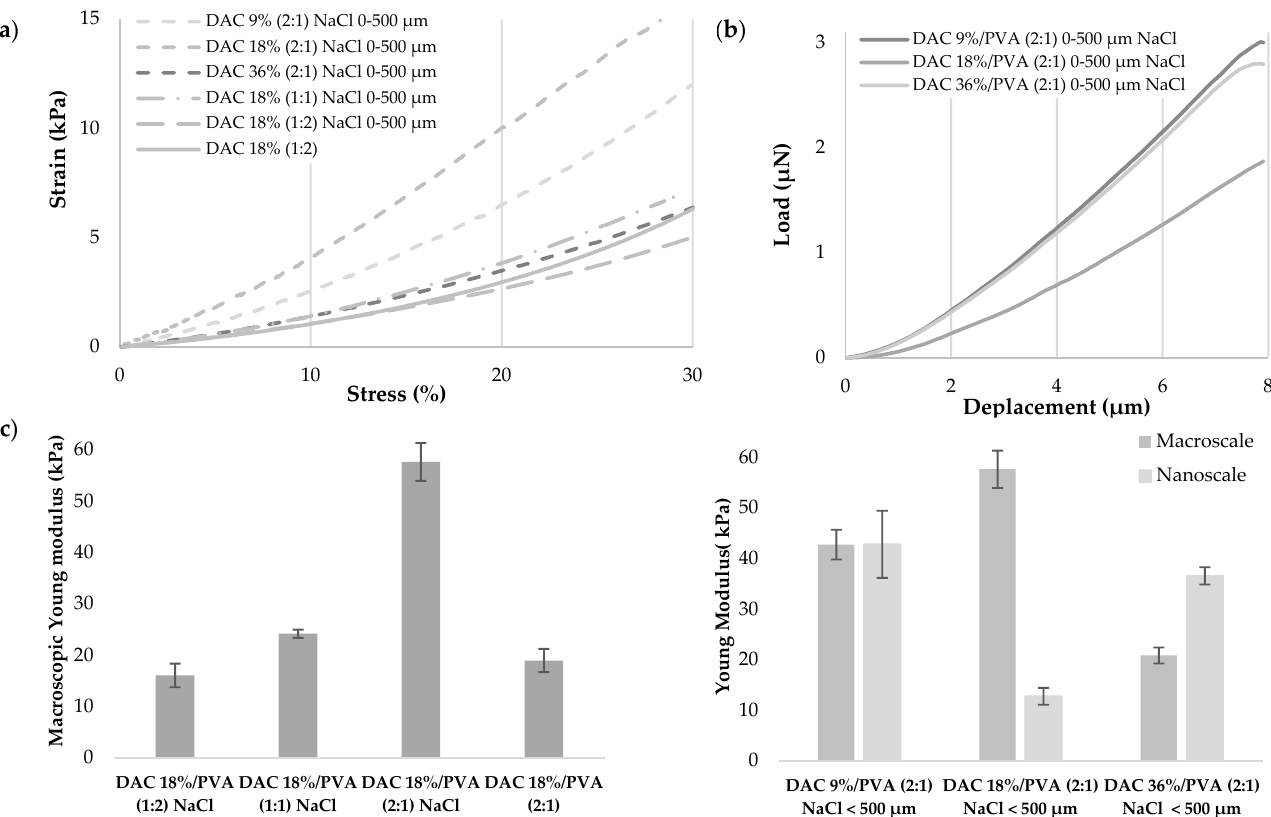
Figure 6. DAC/PVA hydrogels mechanical properties ( a ) Stress-strain curves obtained by compressive test. Compression up to 30%, speed: 0.01 mm/s, sensor: 22N (n = 5); ( b ) Load-deplacement curves obtained upon 15,000 nm at 3 nm/s nanoindentation. Indenter diameter: 28.5 µm, stiffness: 0.47 N/m (n = 3) ( c ) Determination of macroscopic and nanoscopic Young’s modulus. All conditions display *** significance except DAC 9%/PVA (2:1) NaCl < 500 µm samples (*** p -values < 0.001 (ANOVA, Tukey test)).